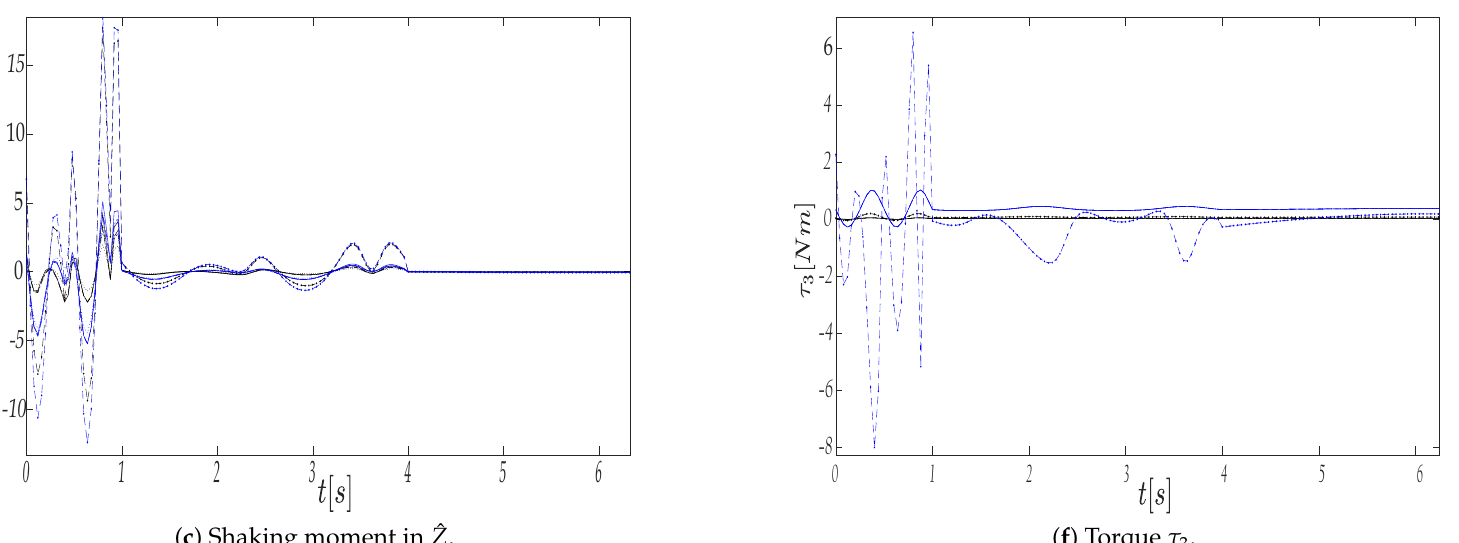
Figure 11. Behavior of the shaking force F Sh , shaking moment M Sh in the lemniscate trajectory. The design behaviors associated with m e = 0 kg are described in lines as RBD, − · − · − DBD, − − −− DTBD, · · · · ·· SMBD, − · − · − SFBD. The design behaviors associated with m e = 0.5 kg are described in lines as RBD, − · − · − DBD, − − −− DTBD, · · · · ·· SMBD, − · − · −